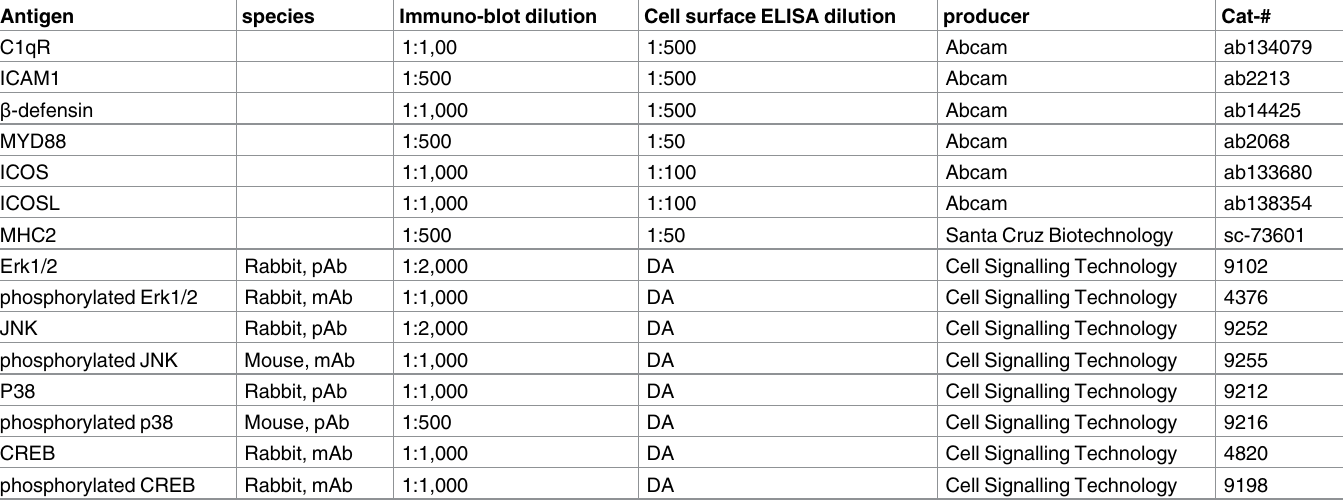
Table 2. Antibodies used for protein